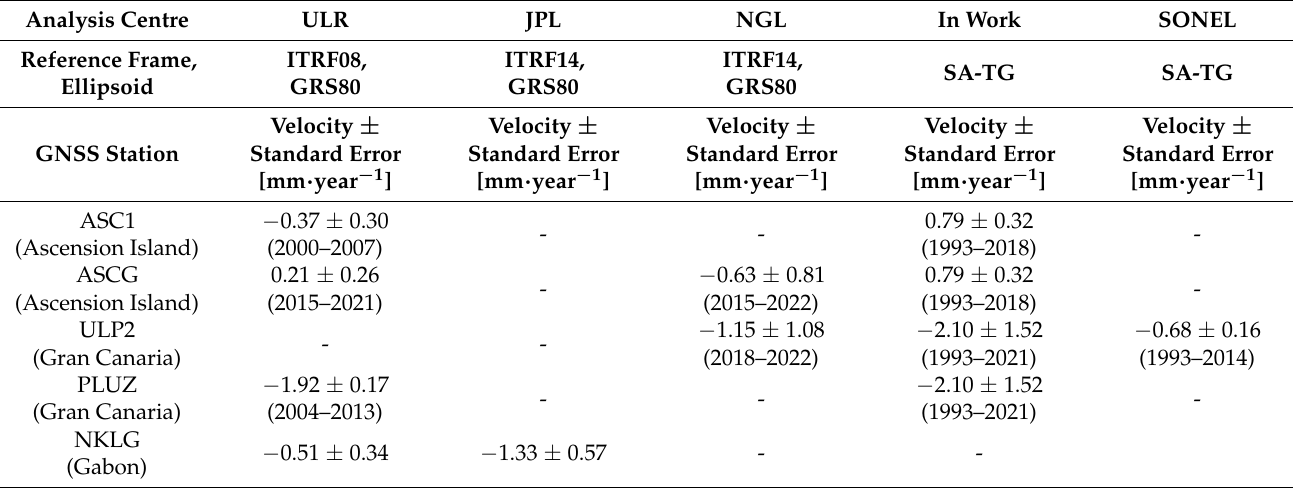
Table 1. Velocities of crust movement calculated in this study are based on GNSS data and SONEL network data calculated by three analytical centers (ULR, NGL, JPL). The last column presents the sea level differences from time series of satellite altimetry minus tide gauge from SONEL